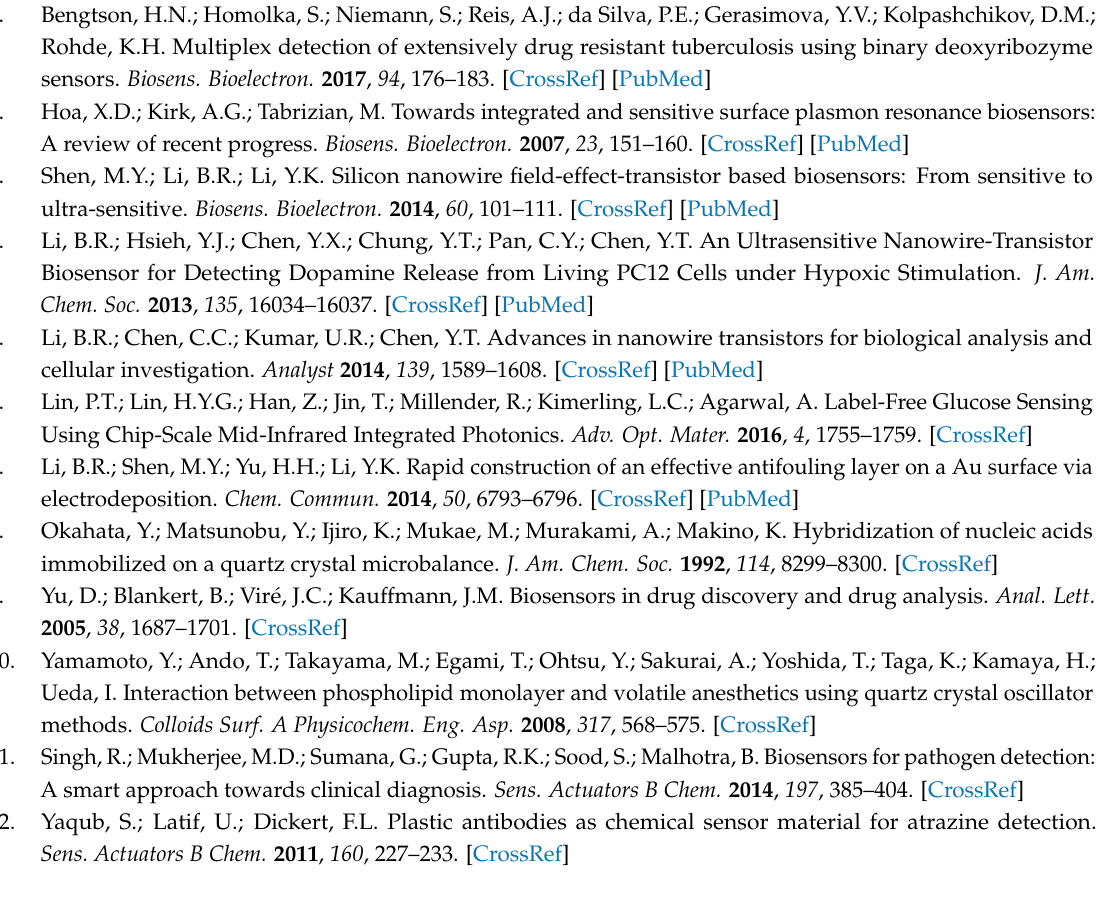
Figure S1: Real-time response of a QCM sensor by injecting sorbitol and mouse IgG. Figure S2: 1 H NMR, 13 C NMR, and ESI+ HRMS spectra of BA-C 2 -AN. Figure S3: 1 H NMR, 13 C NMR, and ESI+ HRMS spectra of BA-C 7 -AN. Figure S4: 1 H NMR, 13 C NMR, and ESI+ HRMS spectra of BA-C 14 -AN. Figure S5: 1 H NMR, 13 C NMR, and ESI+ HRMS spectra of BA-C 5 -SH. Figure S6: 1 H NMR, 13 C NMR, and ESI+ HRMS spectra of BA-C 7 -SH. Scheme S1: Scheme of synthesis of BAC 2 -AN. Scheme S2: Scheme of synthesis of BA-C 7 AN. Scheme S3: Scheme of synthesis of